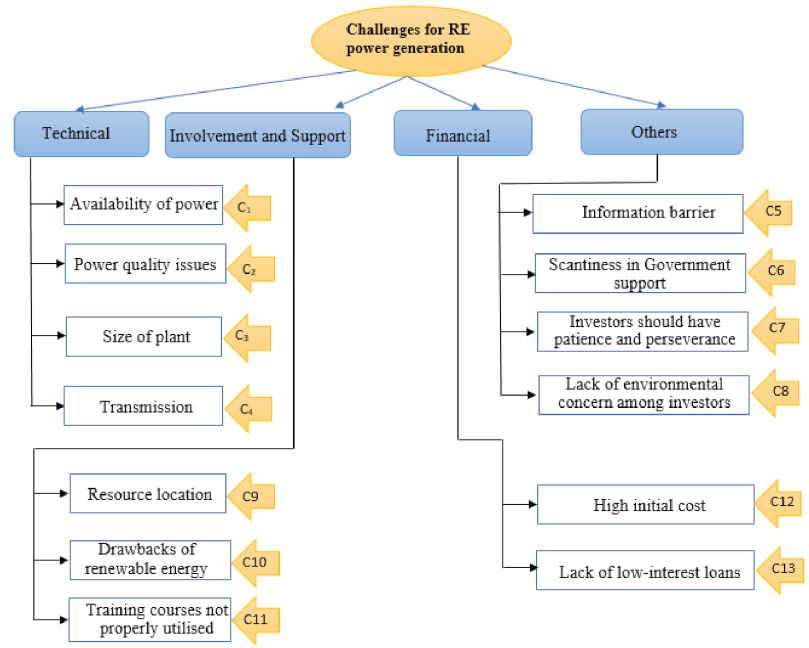
Figure 2. List of criteria considered for the case